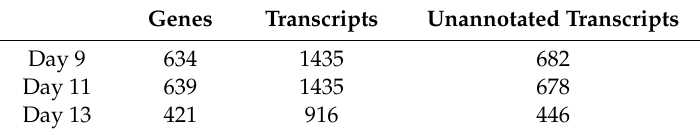
Table 1. Significant genes and transcripts within days nine, 11, and 13 of equine endometrium from pregnant and non-pregnant mares. This table breaks down the number of significant ( p ≤ 0.05) genes and transcripts identified within each day. It also states out of all the transcripts identified how many were previously